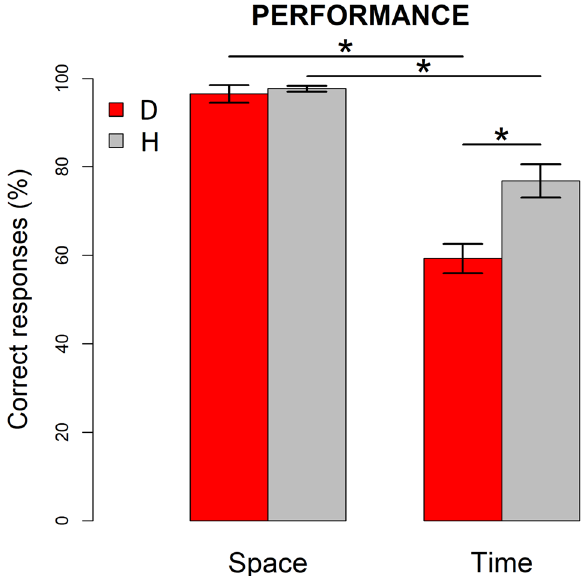
Figure 3. Performance (mean ± SEM) for spatial (left) and temporal (right) bisection tasks in deaf (red) and hearing (grey) subjects. Deaf participants show significantly lower percentage of correct responses compared to hearing participants in time- but not space-bisection. * p < 0.01 after Bonferroni correction.